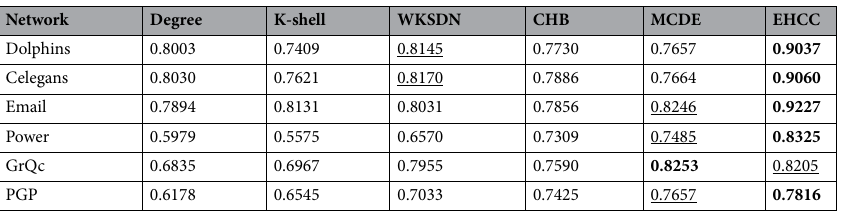
Table 6. The consistency coefficients between the node ranking sequences of the different algorithms and the ranking sequences of the SIR model in the six real networks, where the infection rate α = 1.05 × α th in the SIR model. The highest and second-highest values in each network are highlighted in bold and underlined, respectively.